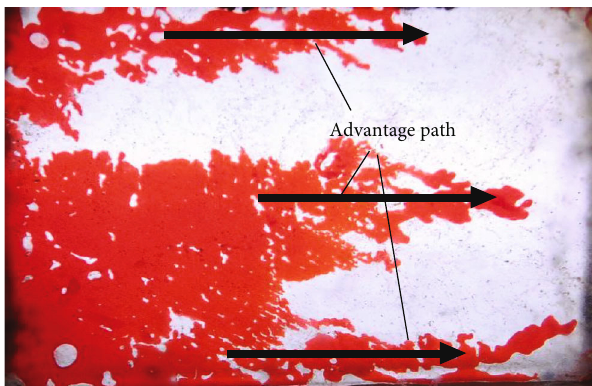
Figure 9: Advantage path in PCE